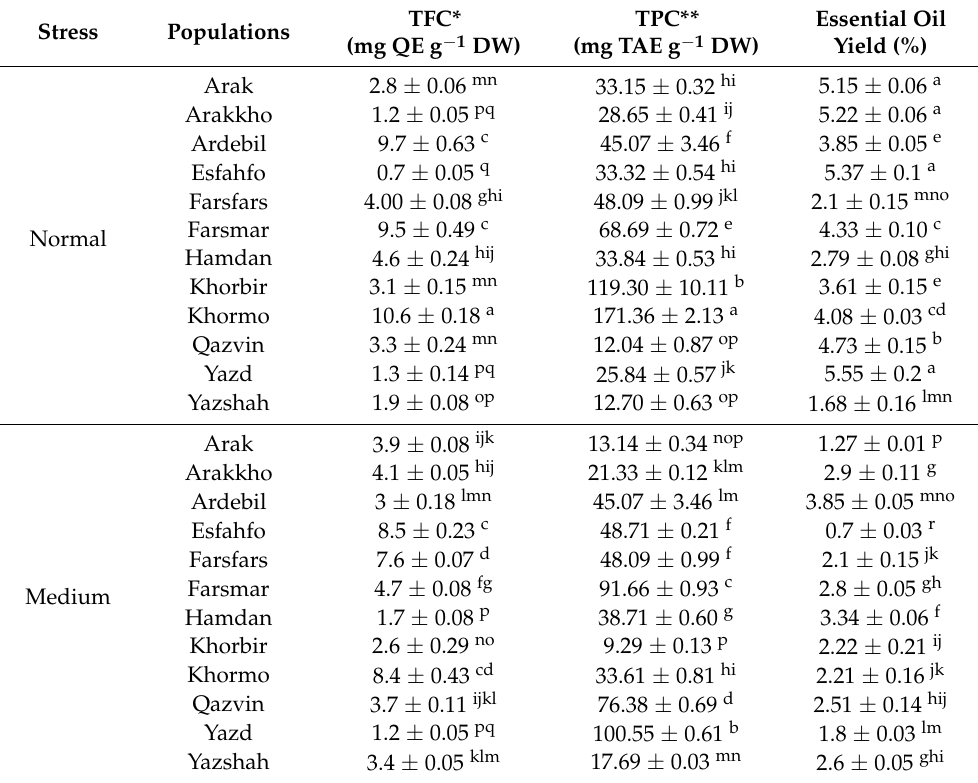
Table 1. Contents of total phenolics, total flavonoids, and essential oil yield of ajowan populations. The values are given as mean ±